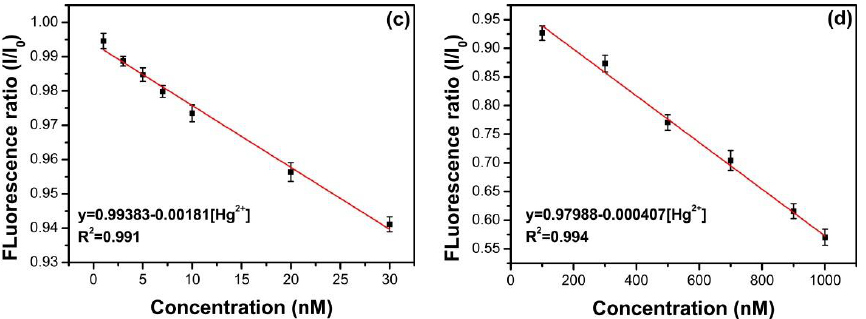
Figure 12. ( a ) Fluorescence response of N, S-GQDs by adding various concentrations of Hg 2 + ranging from 0 to 50 µ M, ( b ) the relationship between fluorescence ratio and Hg 2 + concentration, ( c , d ) the dynamic response range for Hg 2 + detection in the ranges 1–30 nM and 100–1000 nM, respectively. Table 2. Comparison of different fluorescence sensing systems for Fe 3 + detection. LOD: limit of detection. Probe